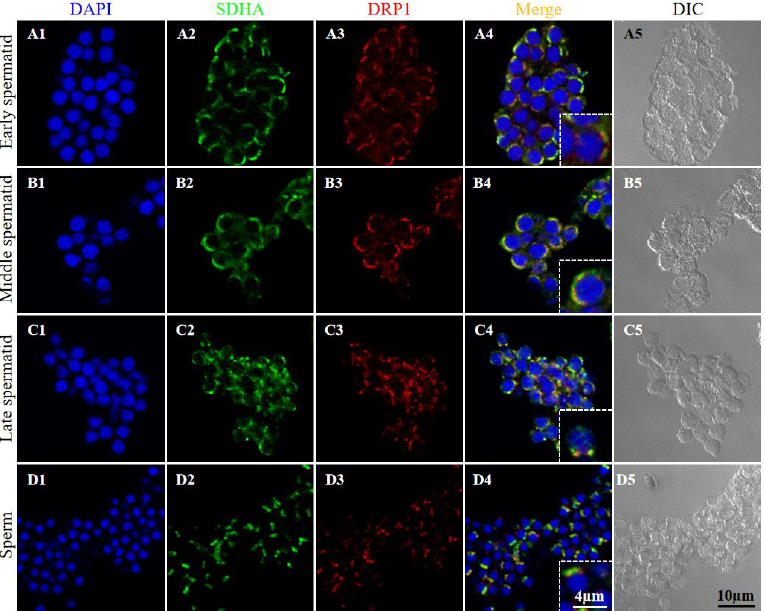
Figure 7. Expression of DRP1 during spermiogenesis in P. esculenta . ( A1 – A5 ) Early spermatid, ( B1 – B5 ) middle spermatid, ( C1 – C5 ) late spermatid, and ( D1 – D5 ) sperm. Blue indicates nuclei stained with DAPI, green indicates SDHA, a mitochondrial marker, and red indicates DRP1. DIC, differential interference contrast imaging.